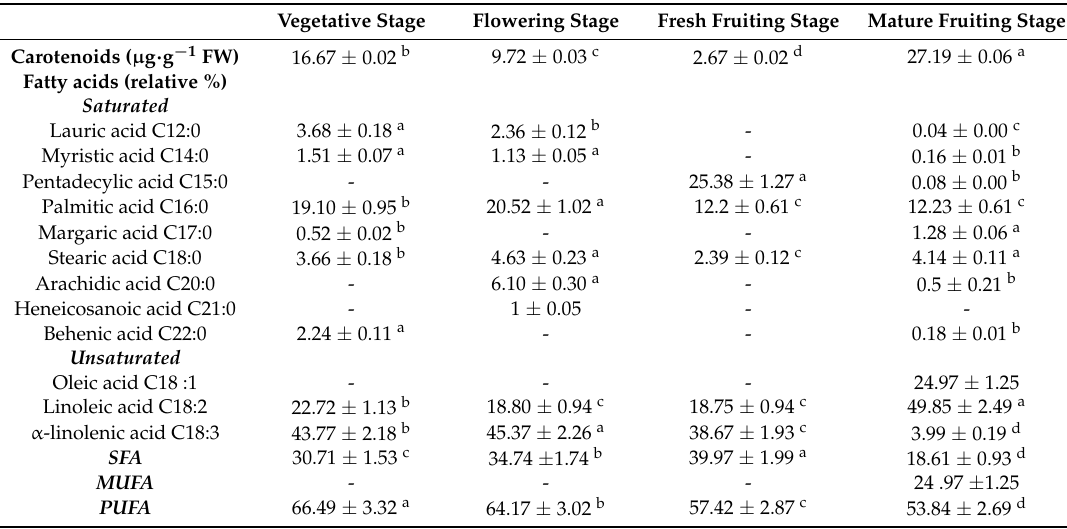
Table 1. Carotenoids ( µ g · g − 1 FW) and fatty acid composition (relative %) in shoots of Retama raetam (Forssk.) Webb at different grown stages. Vegetative Stage Flowering Stage Fresh Fruiting Stage Mature Fruiting